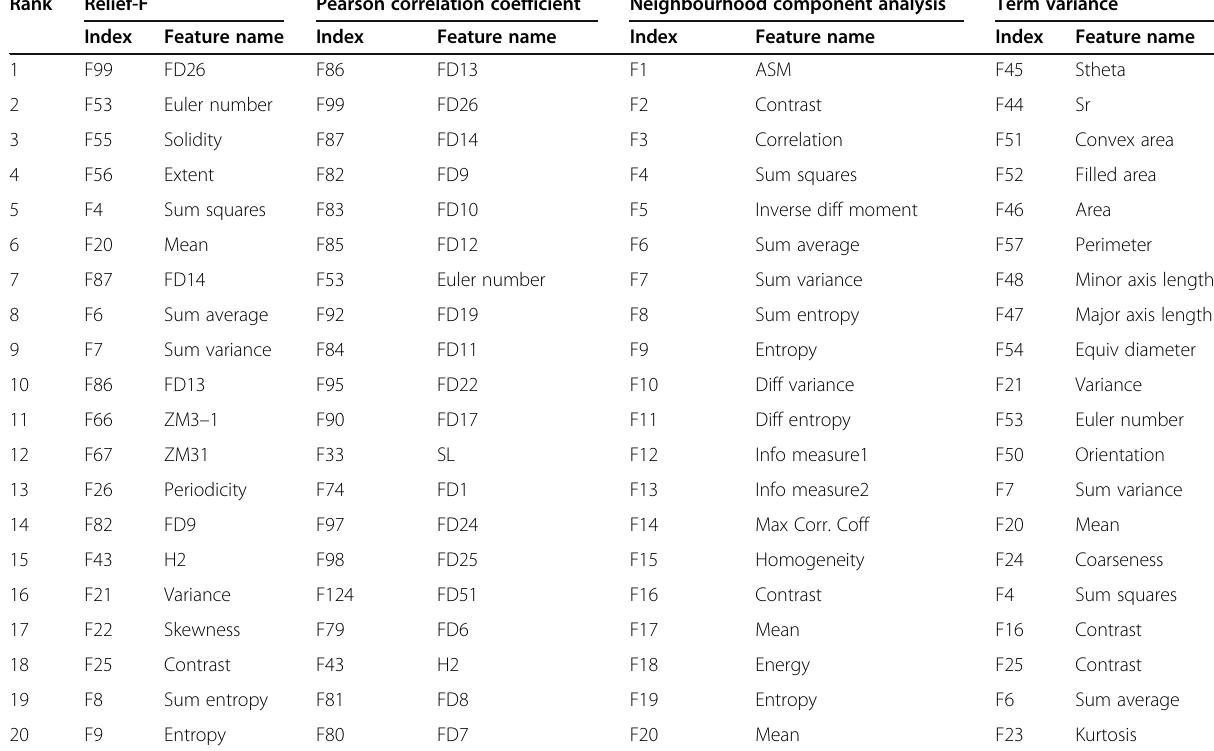
Table 8 Rank-wise lists of the top 20 most discriminative features selected by four different feature selection techniques Rank Relief-F Pearson correlation coefficient Neighbourhood component